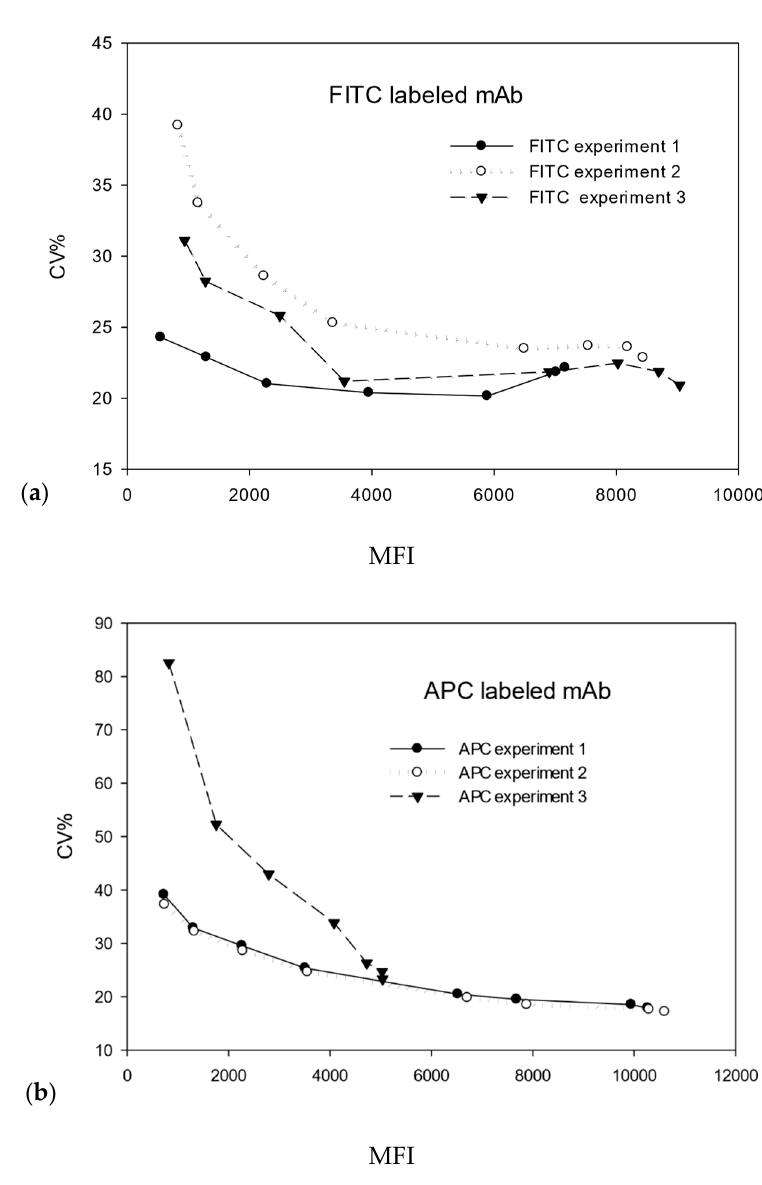
Figure 1. Dependence of CV% on mean fluorescence intensity (MFI) for peripheral blood mononuclear cells (PBMCs) labeled with fluorescein isothiocyanate (FITC) and allophycocyanin (APC). Graphs ( a , b ) show results for three repetitions of the same series of measurements for each label. The large variation in FITC-CV% at small MFI is most likely due to cell settling in the labeling solution. The CV% approaches a reproducible value at large values of MFI, where the monoclonal antibody (mAb) concentration in the labeling solution is much higher.